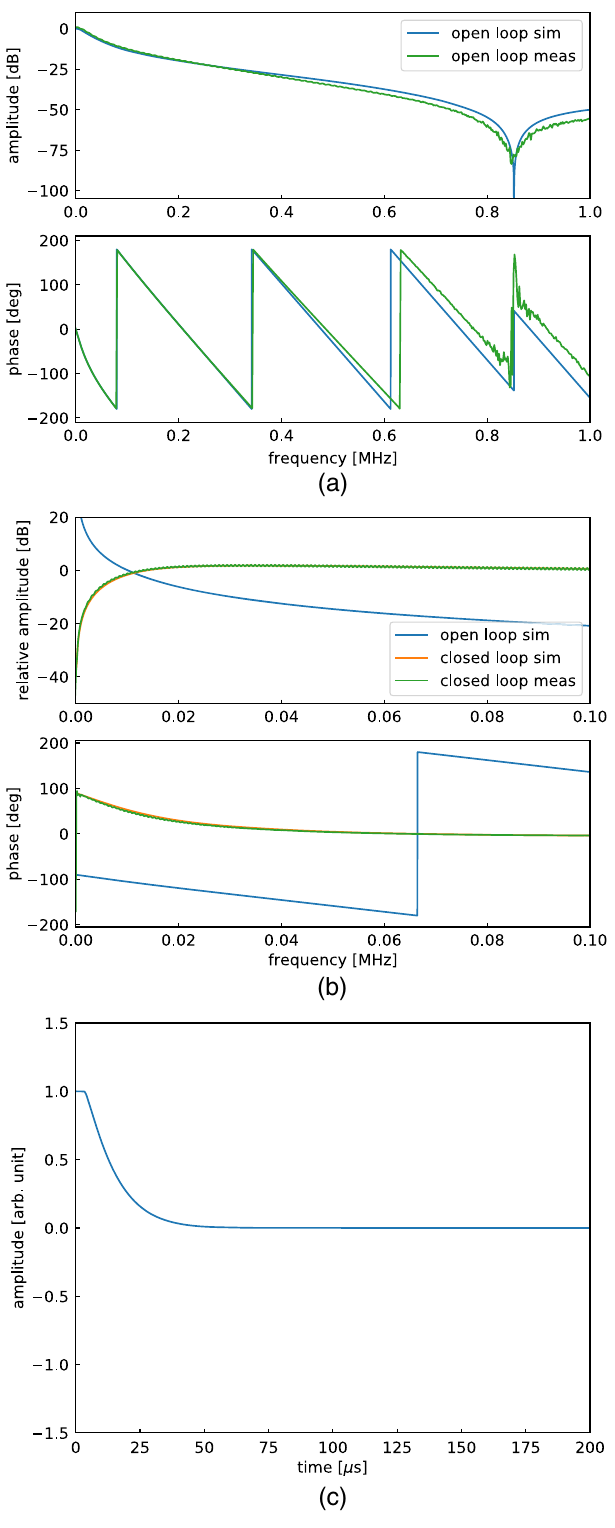
FIG. 21. (Top) Comparison of the measured and simulated open ¼ 3 . 1 μ s and G ¼ 1 . 1 . loop transfer functions where T delay DUT (Middle) Simulated openand closed loop transfer function with the PI gains and the measured closed loop transfer function. (Bottom) Simulated step response with the PI gains, P ¼ 3 and I ¼ 15 .